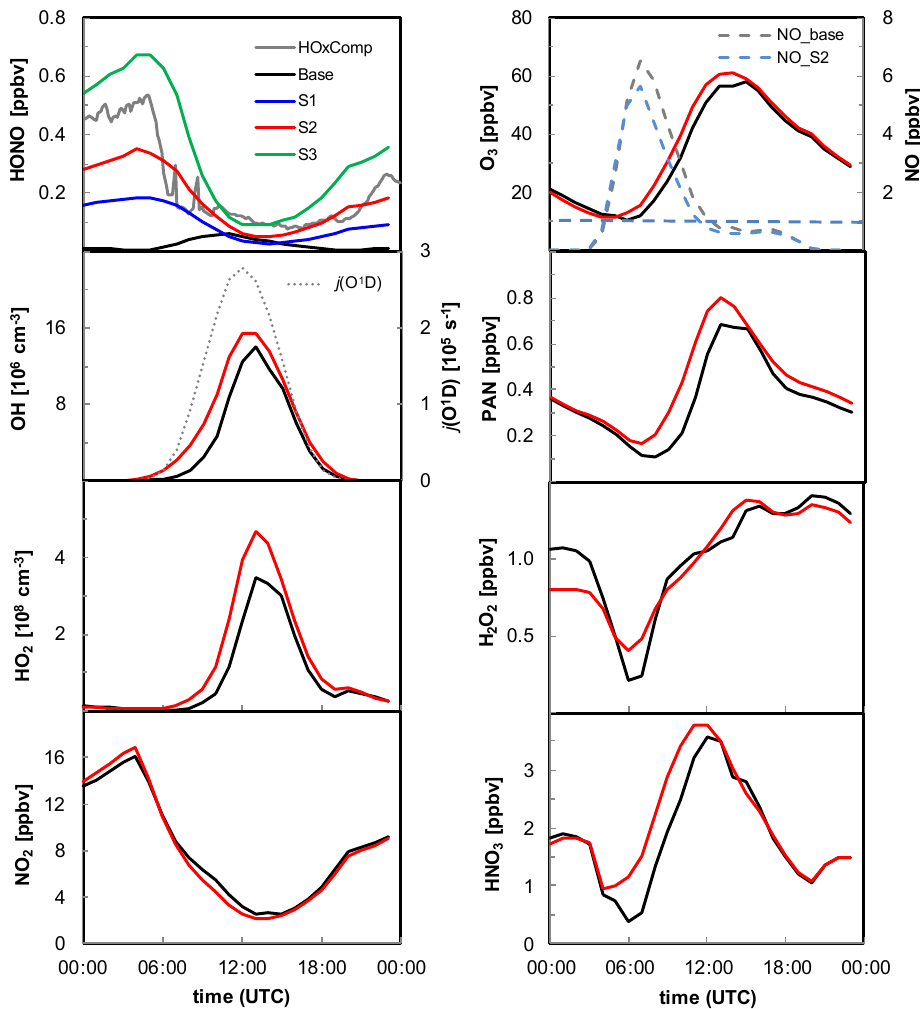
Fig. 13. Simulated diurnal cycles for 10 July 2005, in Northwest Germany (50.93 ◦ N, 6.36 ◦ E) compared to the measured HONO diurnal Figure 13: Simulated diurnal cycles for 10 July, 2005, in Northwest Germany (50.93°N, profile during the HOxComp campaign near J¨ulich in Germany (50.91 ◦ N, 6.41 ◦ E, from Elshorbany et al., 6.36°E) compared to the measured HONO diurnal profile during the HOxComp campaign near Jülich in Germany (50.91°N, 6.41°E, from Elshorbany et al., 2012).